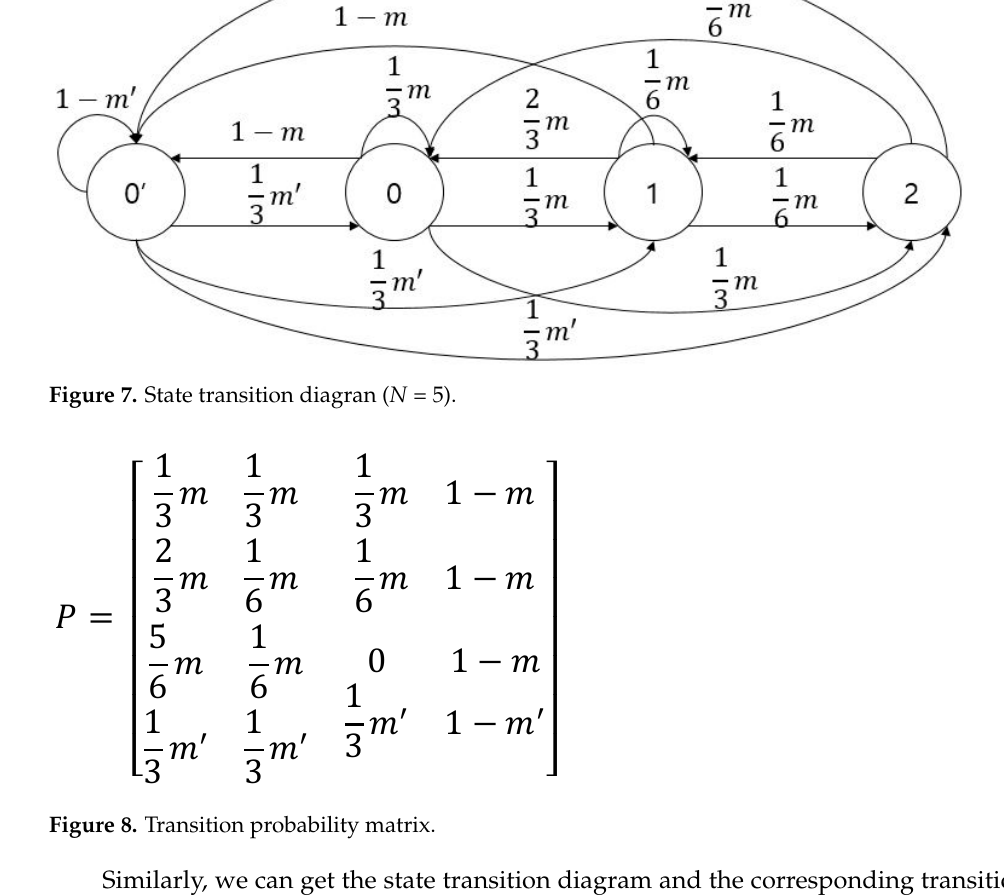
Table 2. State of each cell in location area and transition probability matrix for various N.